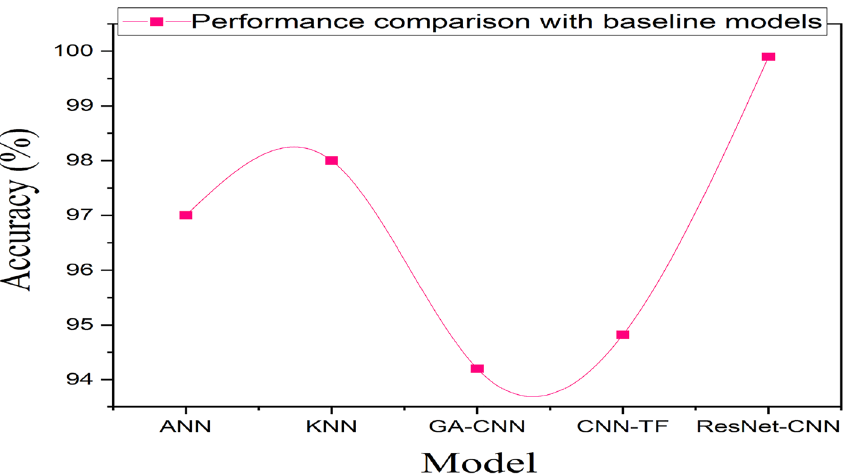
Figure 5. ResNet-CNN model performance comparison with baseline models show that our model predictive performance in terms of accuracy is high from baseline models. The ResNet-CNN model cloud accurately and efficiently classify the brain tumors and assist medical experts to interpret the images of brain tumors to diagnosis brain